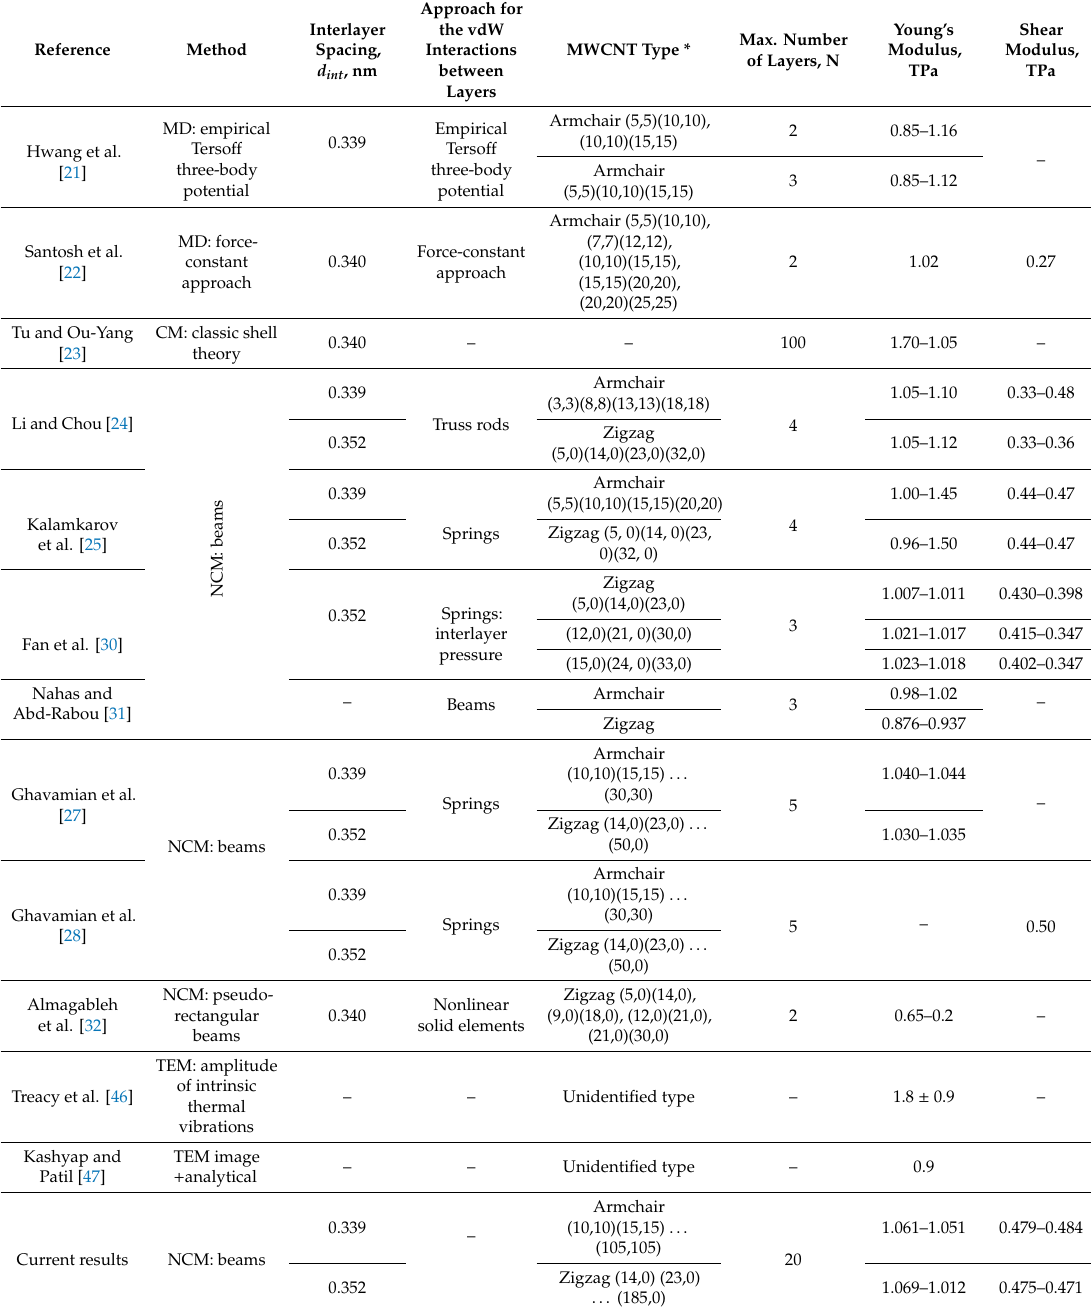
Table 6. Comparison of the current results of the elastic moduli results with those reported in the